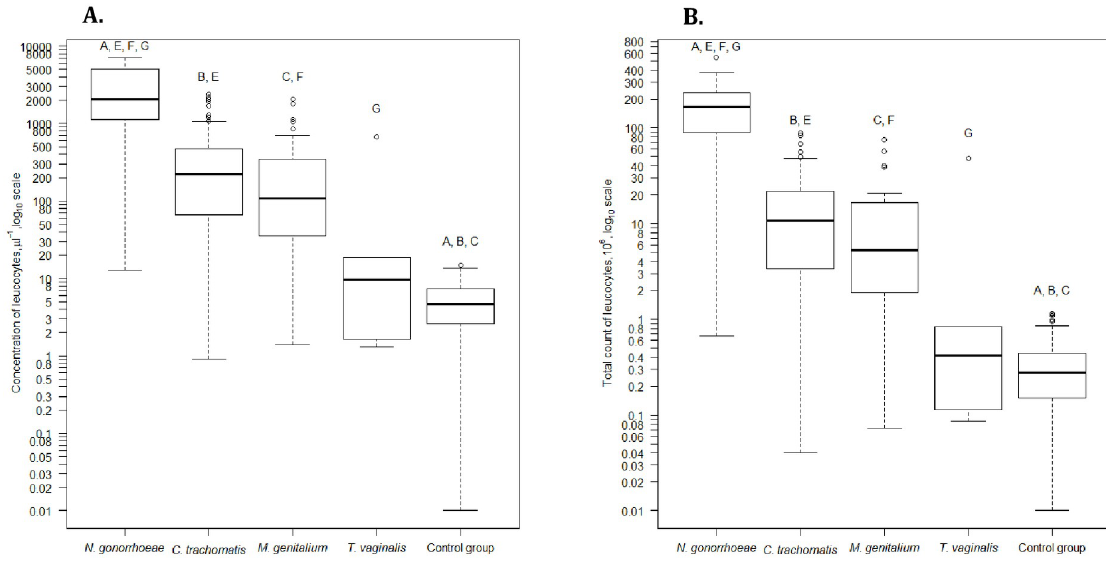
criteria to deciding whether to test for NG, CT, MG and TV, we could miss 21 monoinfections and 2 combined STI cases that makes up 7,5% of all STI positive cases. Data about the flow-cytometric inflammatory reaction and bacteria in case of combined infections are presented in S2 and S3 Tables. The highest white blood cells (WBC) values were